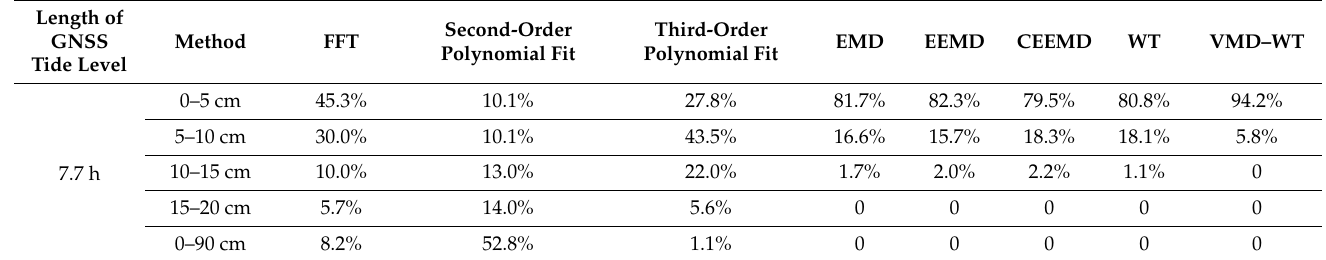
Table 2. Extraction error distribution of the eight filtering methods for 7.7 h.